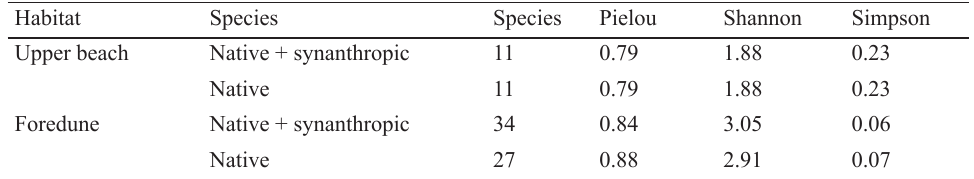
Table 7. Diversity, richness and evenness indices